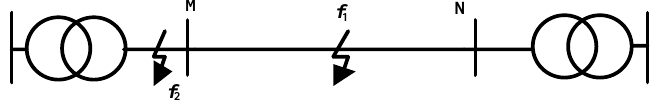
Figure 2. Two-terminal alternating current (AC) transmission system.